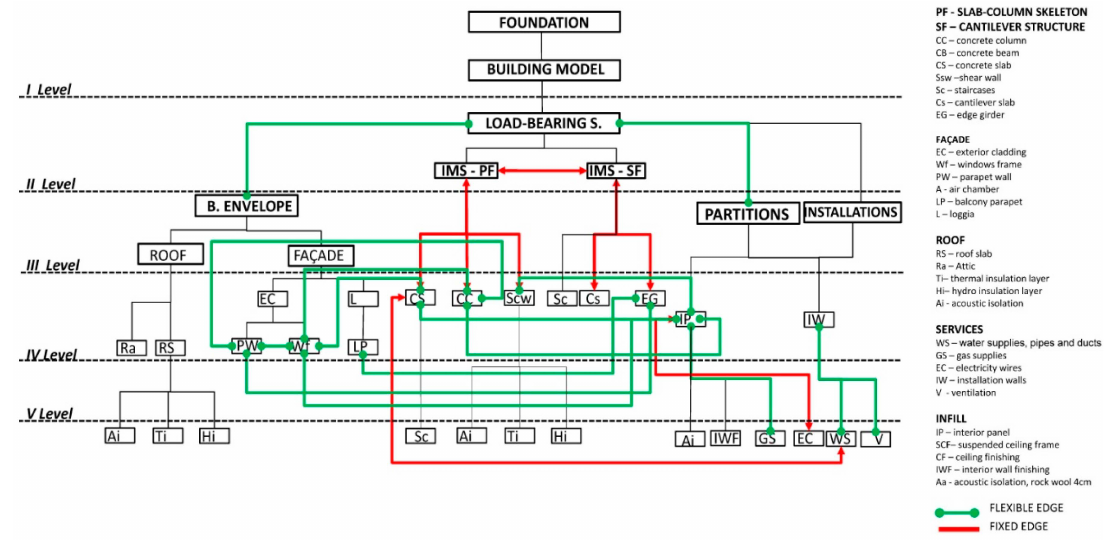
Figure 9. Graph Model for housing building in Block No. 1: Systematic approach of IBM according to independent technical